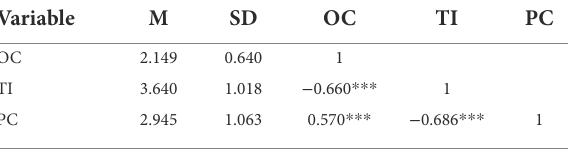
TABLE 1 Variable descriptive statistics and correlation